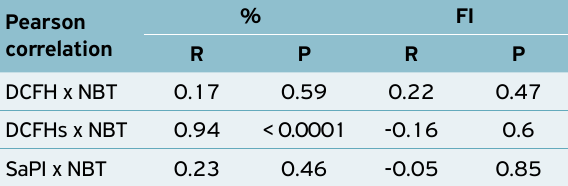
Table 3. Pearson correlation (R) of AM functions of calves at basal (M1) and immunosuppressing moment